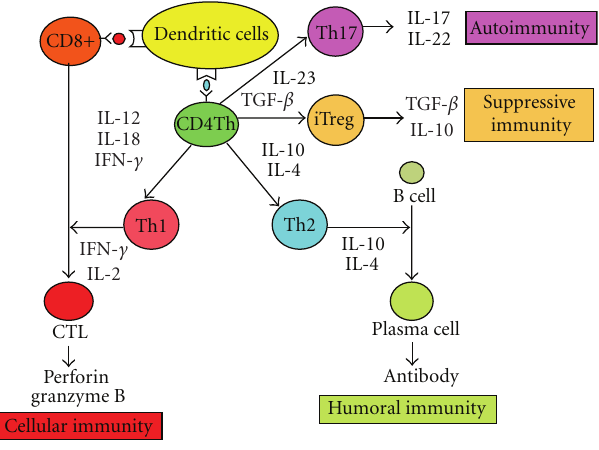
Figure 1: The role of helper T cells in tumor immunity. CD4+ T-helper cells play extensive roles and are able to interact with the tumor cell and immune e ff ectors. Th1 cells secrete type I cytokines such as interleukin 2 (IL-2) and IFN- γ , resulting in the activation of DCs, which can stimulate CTLs. Tumor-specific Th1 cells regulate the survival and persistence of CD8+ e ff ector T cells as memory cells. Th2 cells secrete type II cytokines, such as IL-4 and IL-10. Th2 cells can enhance the generation of humoral, antibody-based antitumor responses. Th17 cells secrete IL-17 elicit tissue inflammation implicated in autoimmunity. Inducible CD4+ regulatory T cells (iTreg) exhibit a strong immunosuppressive activity for antitumor immunity.